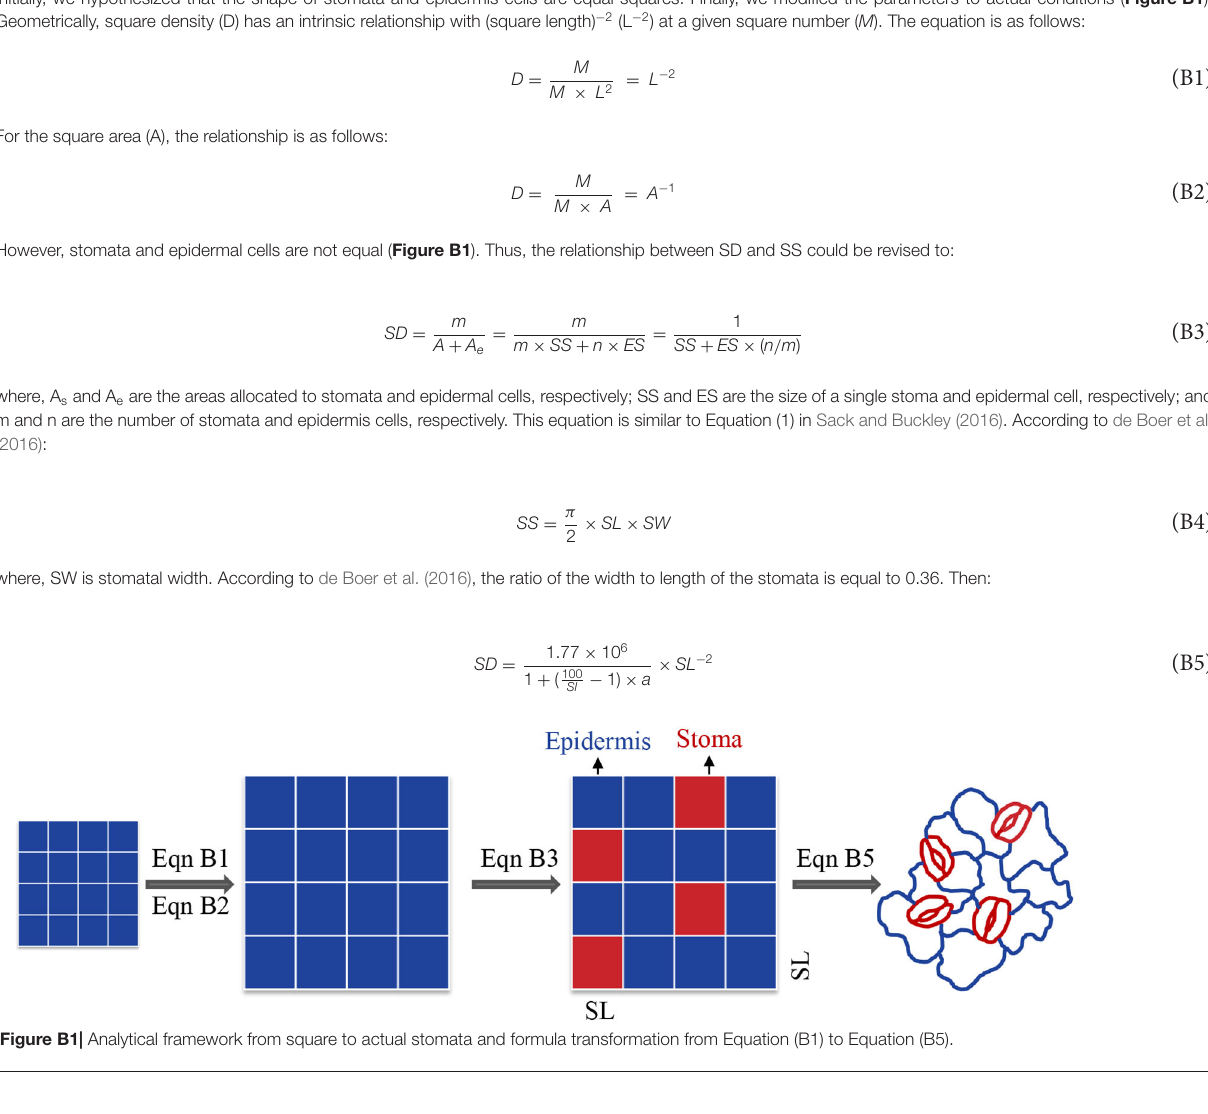
close to observed SI values, a was modified to 1.06 ( Figure 2C